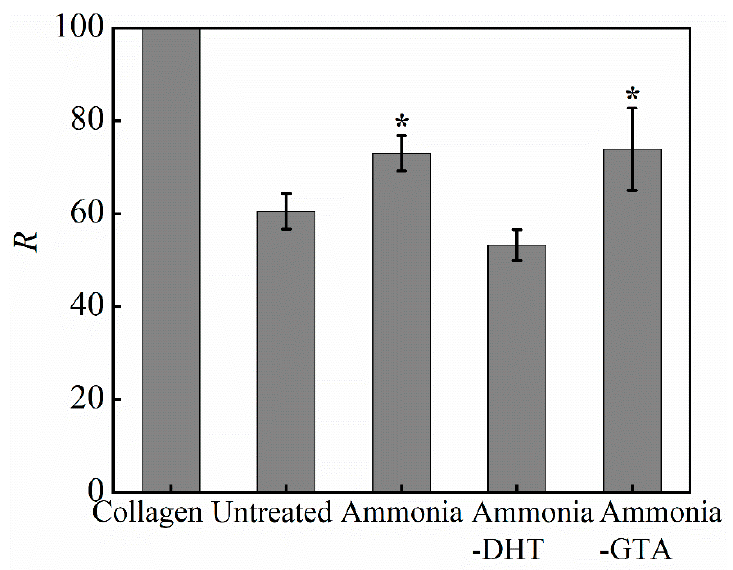
Figure 4. The ratio R representing the degree of denaturation of original lyophilized collagen and electrospun collagen tubes before and after various treatments. * p < 0.05, collagen tubes with ammonia treatment and ammonia-GTA treatment are significantly different from untreated collagen tube.